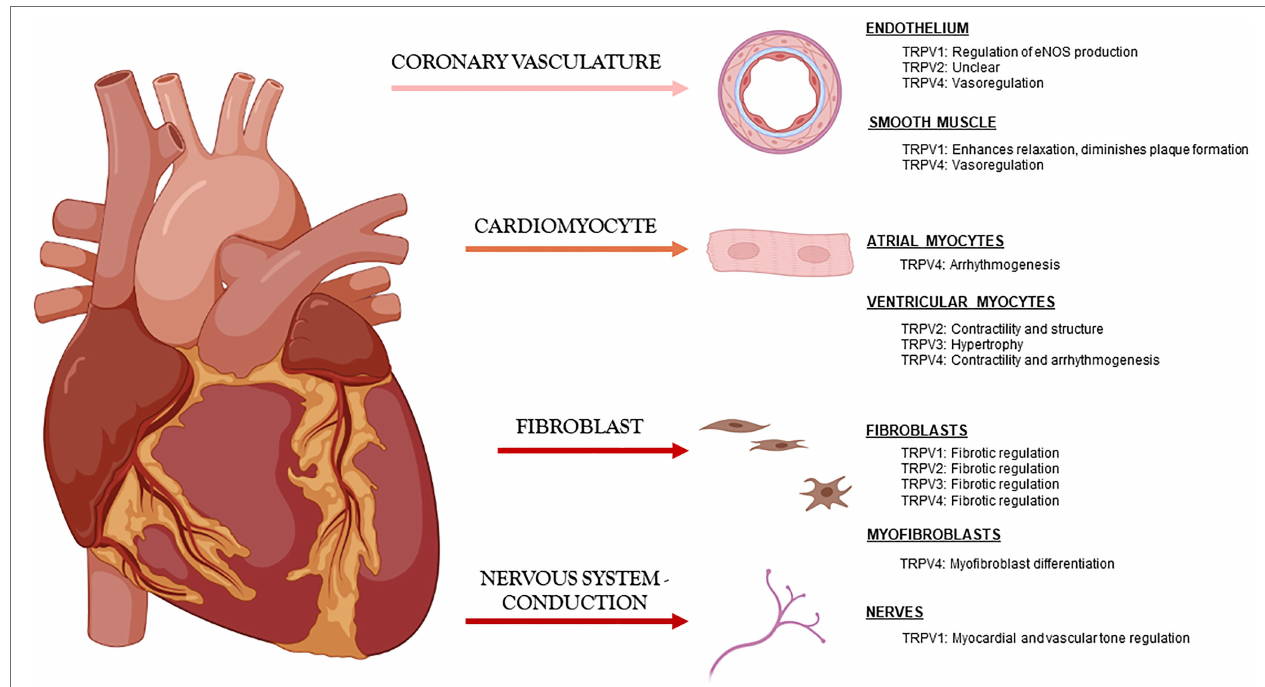
FIGURE 1 | Known roles of TRPV channels in cardiac tissue under physiologic